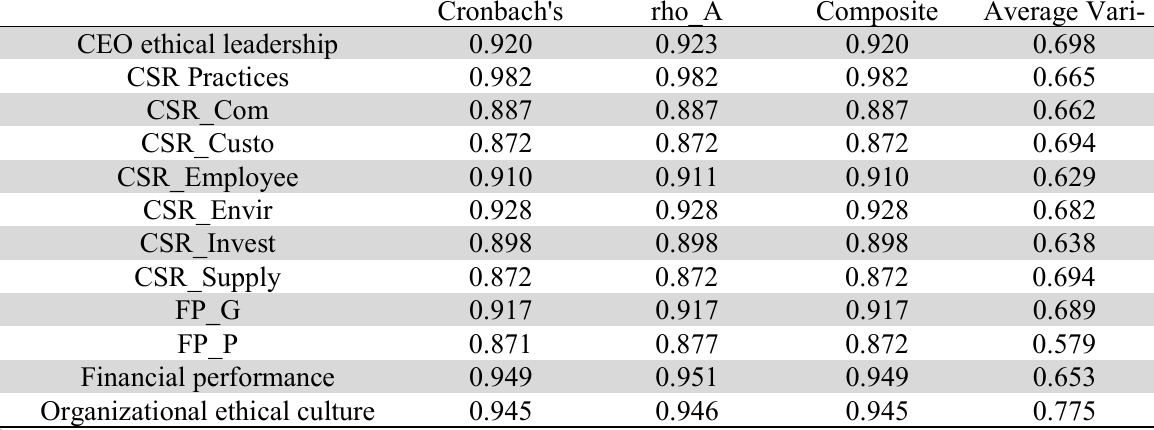
Construct Reliability and